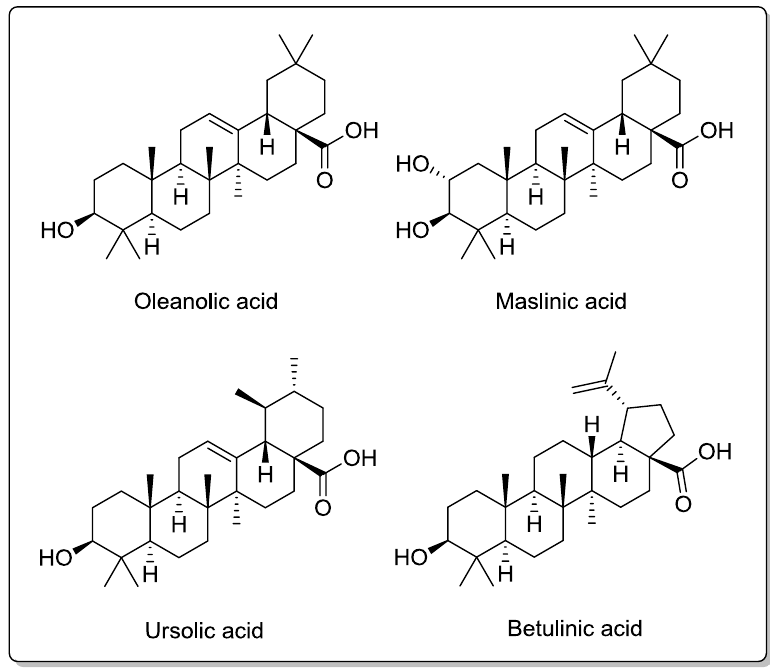
Figure 4. Chemical structures of triterpenic acids present in olive